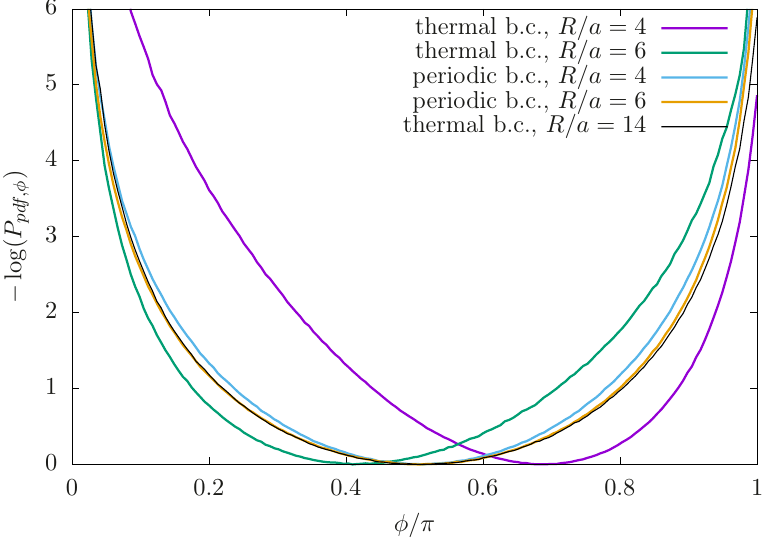
Figure 8 . Constraint effective potential from the per-site distribution of the Polyakov phase φ comparing periodic and thermal fermion boundary conditions. The minimum at φ > π/ 2 and φ < π/ 2 for N t = 4 and N t = 6 in the thermal case indicates the negative and positive average value of the Polyakov line in the center broken phase. The histogram has been determined the same runs as in figure 6. The plot in this representation can be directly compared to the pure gauge case [51].